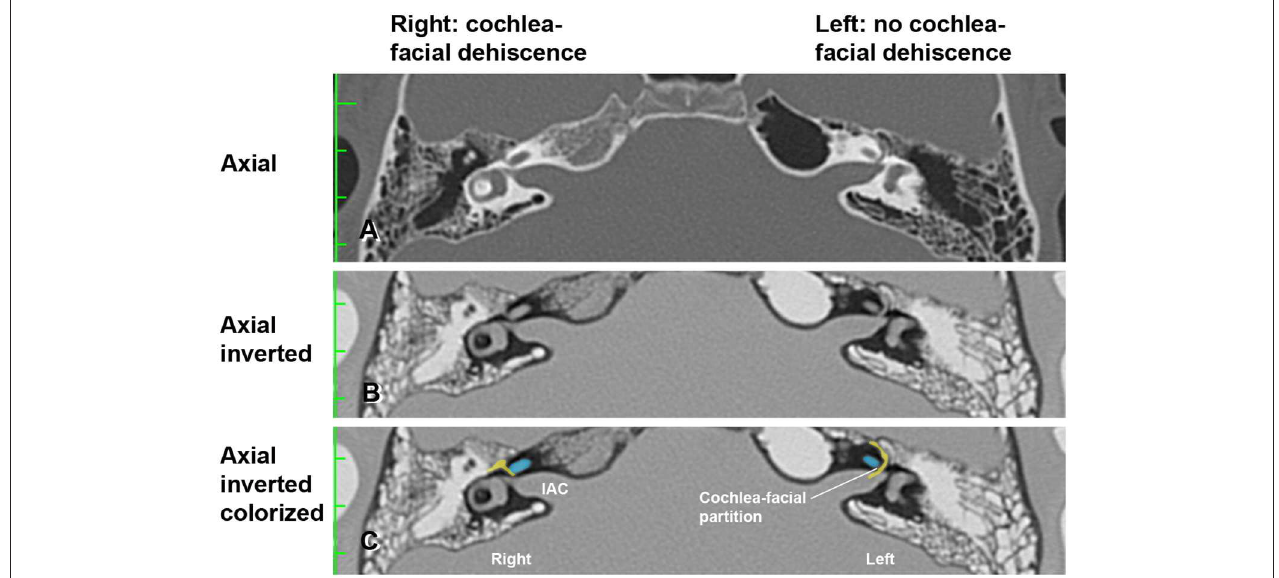
FIGURE 2 | High-resolution temporal bone CT without contrast ( Table 1 , Group 1 Patient 2). (A) Traditional axial CT images are shown. (B) Inverted axial CT images. (C) Cochlea (blue) and facial nerve (yellow) have been colorized and superimposed over inverted images in the axial plane for both the left and right ears. Note that a cochlea-facial nerve dehiscence (CFD) is seen on the right and a cochlea-facial partition between the cochlea and the facial nerve is seen on the left. The patient had left-sided third window syndrome (TWS) symptoms due to a CT negative TWS, with resolution of his TWS symptoms after round window reinforcement on the right and left. IAC, internal auditory canal. Copyright © P.A. Wackym, used with permission.